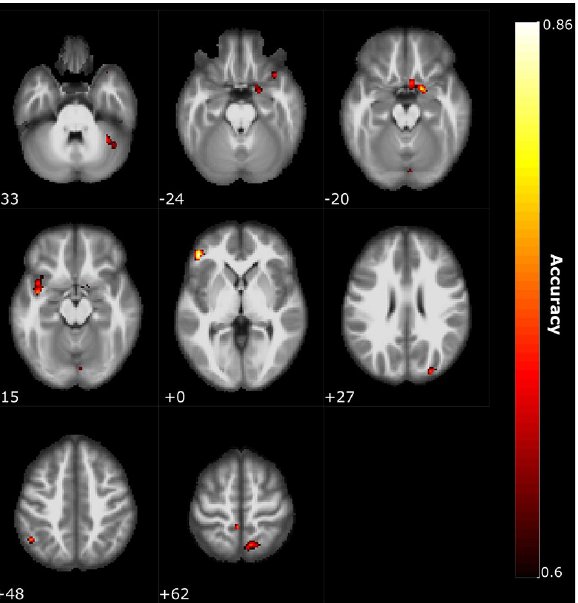
Figure 1. Multivariate pattern analysis. Multiple clusters were found where grey matter volume patterns differentiated between the two groups with classification accuracies between 76 and 86%. Clusters were found within areas associated with olfactory, motor, and multisensory processing (Table 1 and Supplementary Fig. 1). Color scheme indicates accuracy level and numbers within figure indicate slice in z-coordinate according to the